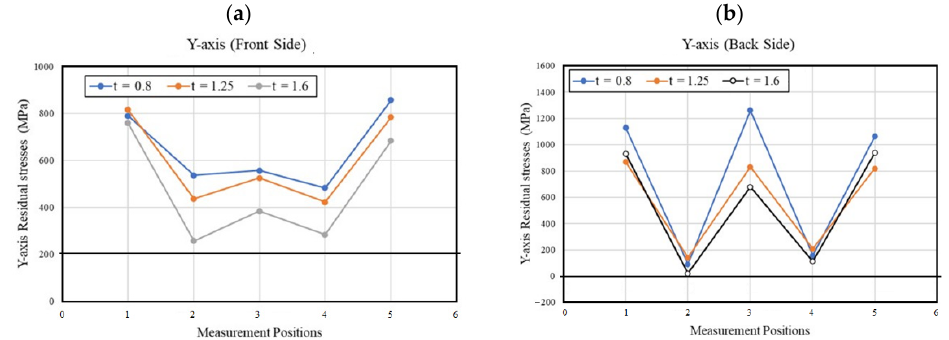
Figure 8. Residual stresses with corresponding measurement locations for the Y-axis of the ( a ) front side, ( b ) back side.